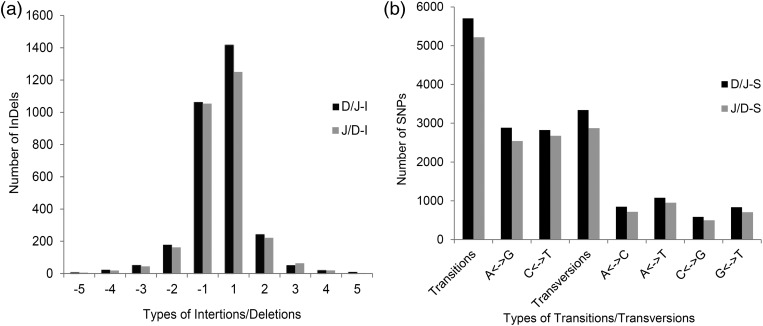
Characteristics and distribution of InDels and SNPs in two RAD libraries. (a) Distribution of insertions (+) and deletions (−). (b) Transitions and transversions occurring within the mined SNPs.